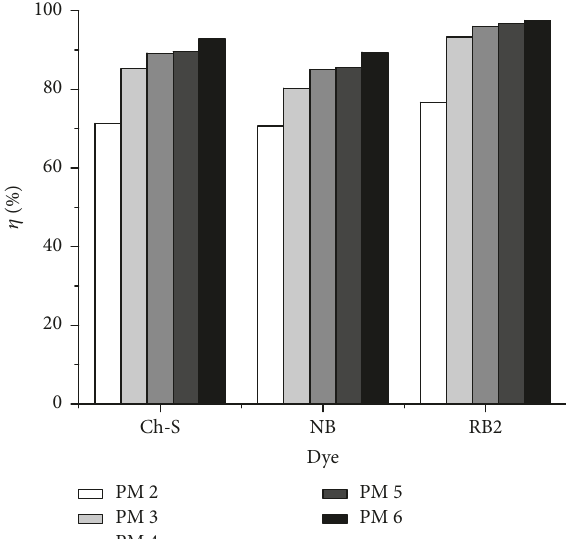
Figure 5: Influence of magnetite/carbon ratio on removal efficiency (dyes concentration 100mg L −1 , 25 ∘ C, pH 7.4 for NB, 7.1 for ChS, and 6.7 for